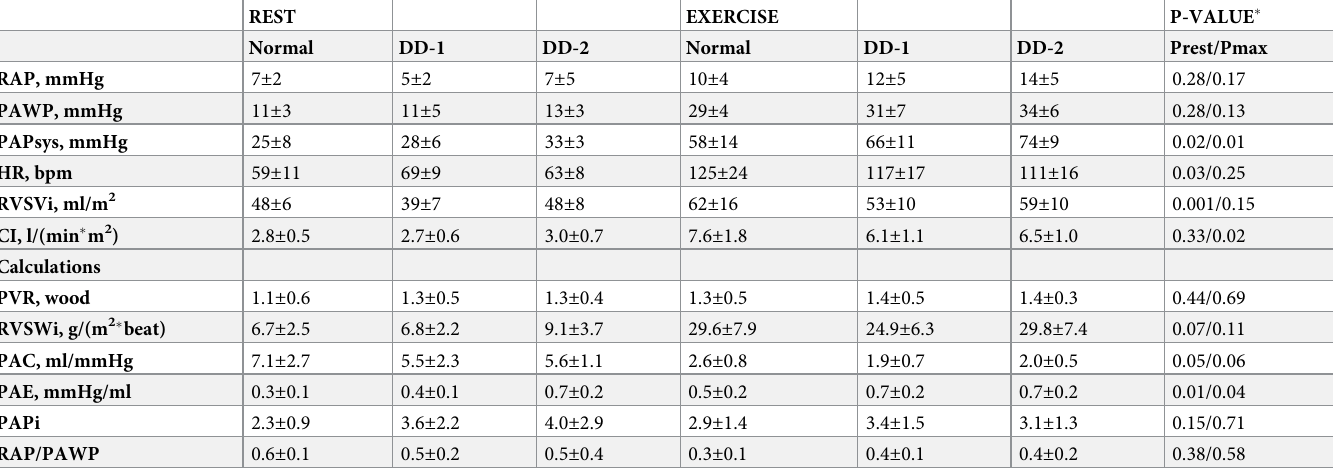
Table 3. Hemodynamic measurements and calculations according to LV diastolic function at rest and during maximal exercise. REST